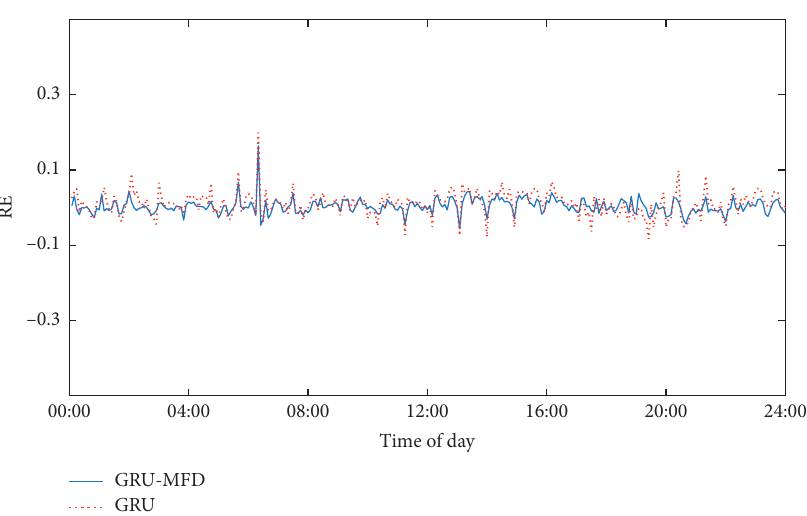
Figure 11: Errors on July 2, 2018, Section